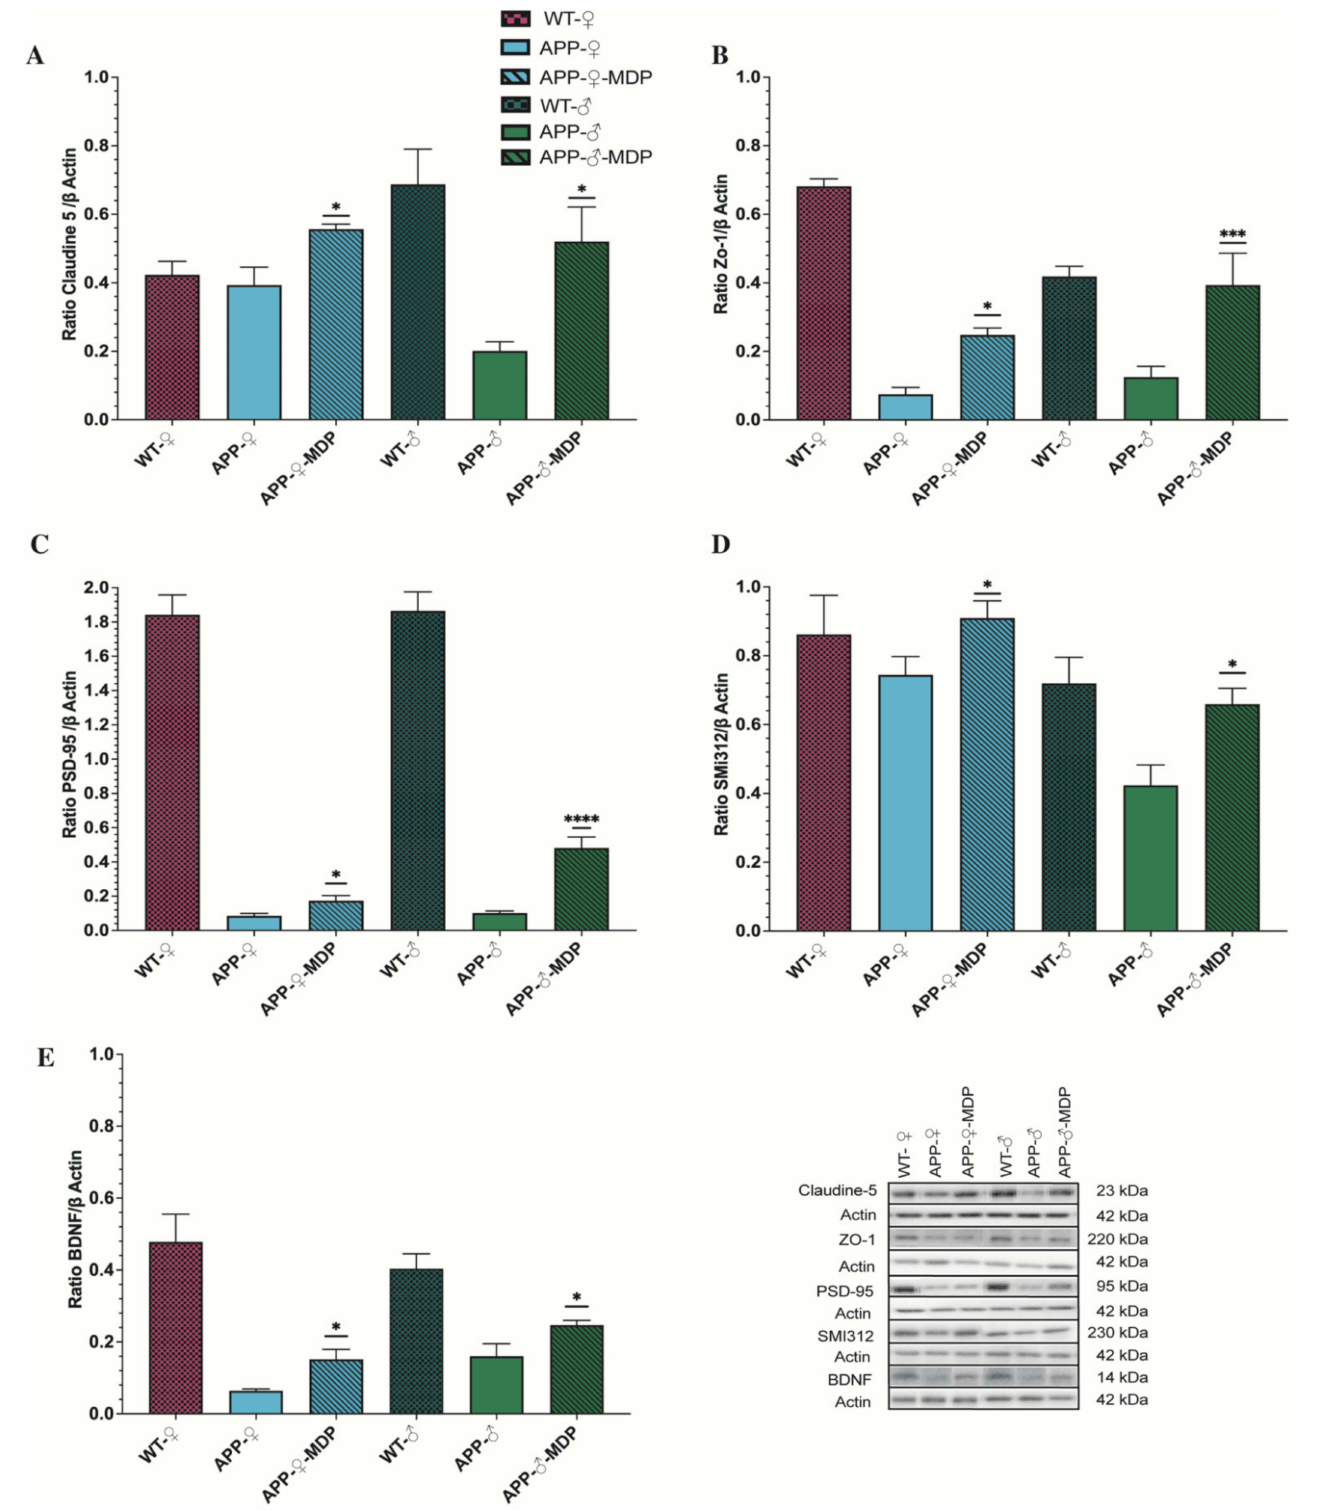
Figure 6. MDP prevents BBB degradation in males and females with conservation of pre- and postsynaptic factor. Western blot analysis of ( A ) Claudin-V, ( B ) ZO-1, ( C ) PSD-95, ( D ) SMI312, and ( E ) BDNF of the male or female wild-type and APP Swe /PS1 treatment or not with MDP groups. Data are mean ± SEM ( n = 8 animals/group). * p < 0.05, *** p < 0.001, **** p < 0.0001 compared to sex-matched APP Swe /PS1